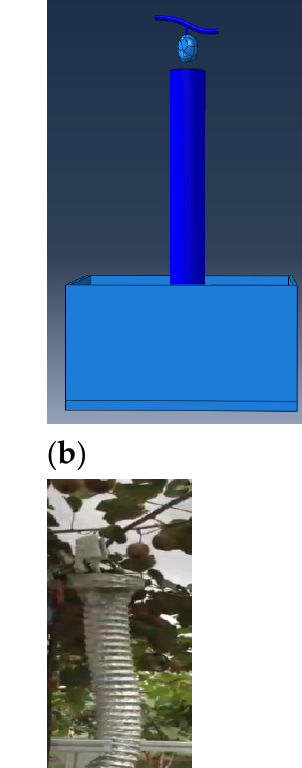
contact, which allowed each node on the outer surface of the peel to effectively interact with the points on the lower surface of the plate. The contact interaction characteristics of the master–slave surface followed the normal “hard” contact behavior, ensuring that each constraint position could not penetrate the peel and that there was no limit to the amount